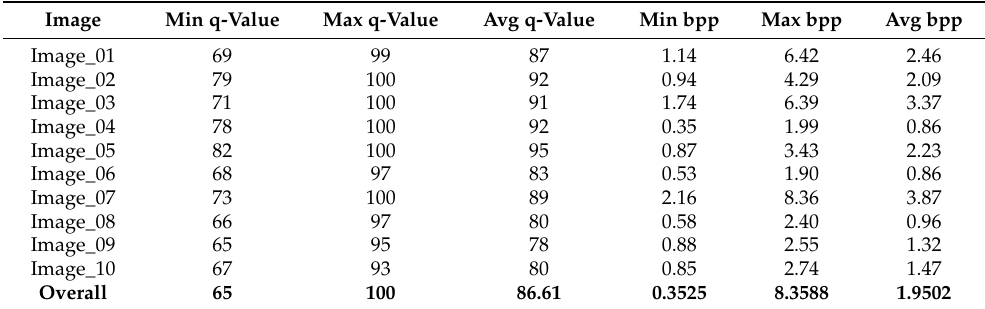
Table 2. Test images with corresponding q-values and bpp values recorded by the flicker test in the proposed subjective test at the point of visually lossless compression.